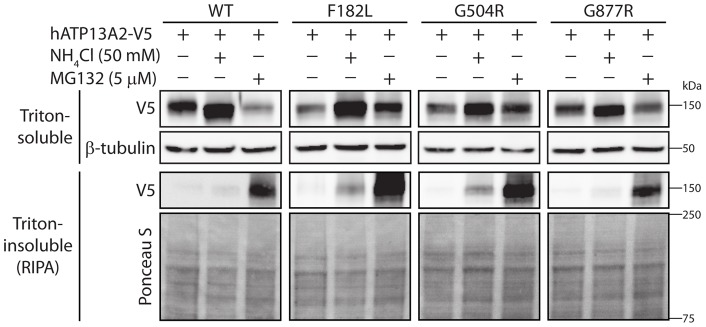
Homozygous missense mutations enhance the degradation of ATP13A2 by the proteasome.HEK-293T cells transiently expressing V5-tagged human ATP13A2 (WT, F182L, G504R and G877R) were treated with the proteasome inhibitor, MG132 (5 µM), or the lysosome inhibitor, ammonium chloride (NH4Cl, 50 mM), for 24 h. Triton-soluble and Triton-insoluble (RIPA-soluble) fractions were probed with anti-V5 antibody to monitor ATP13A2 levels, or with β-tubulin antibody (or Ponceau S stain) to demonstrate equivalent protein loading. Inhibition of the proteasome leads to the marked recovery of F182L and G504R protein variants compared to WT and G877R ATP13A2 in the Triton-soluble and -insoluble fractions. Molecular weight markers are indicated in kilodaltons (kDa). Blots are representative of at least four independent experiments.